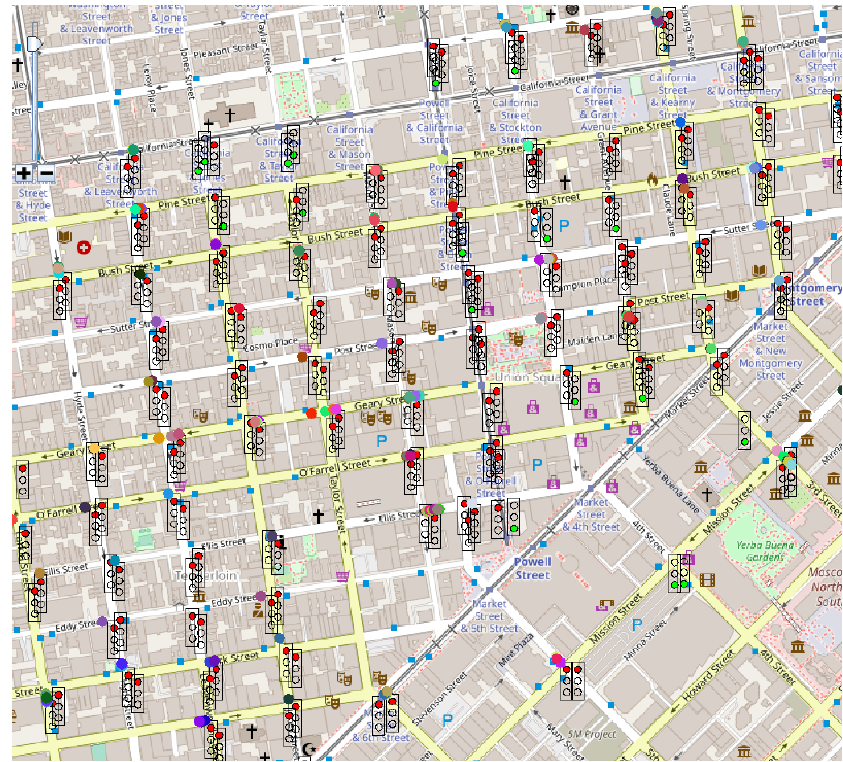
Figure 13. Sim2Car screenshot for traffic conditions in San Francisco.